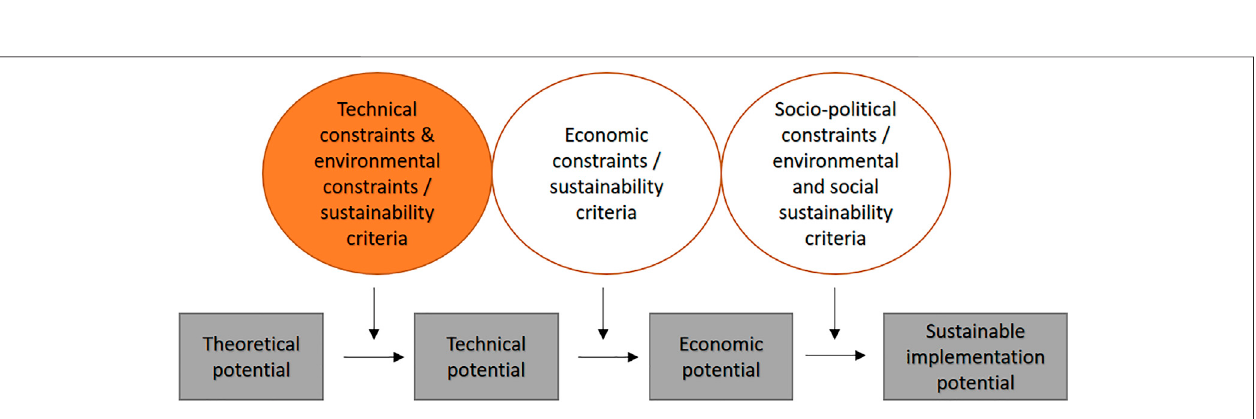
FIGURE 9 | Biomass potential classi fi cation, adapted from (S2Biom Project).